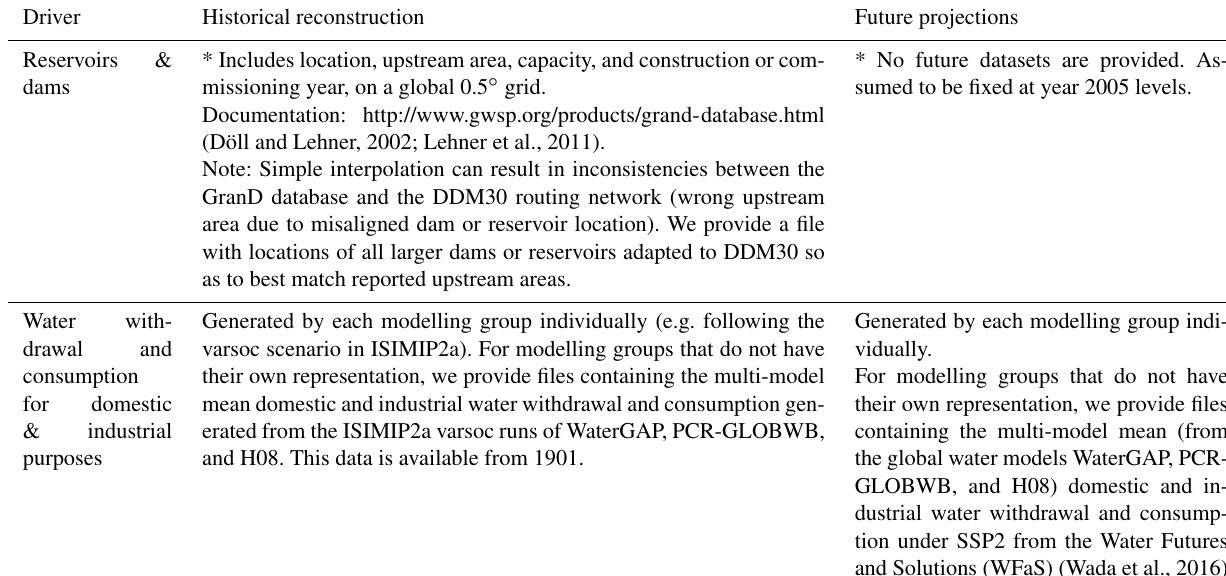
Table 4. Representations of socio-economic drivers for the historical simulations (histsoc, Group 1) and the future projections accounting for changes in socio-economic drivers (rcp26soc or rcp60soc, Group 3). * at the beginning of an entry means that it is mandatory to use the dataset(s) provided (if applicable), for reasons of harmonization across models. In other cases, datasets are provided only in support of modelling groups who may need them, but groups are free to use other data or generate the data based on their own simulations following the rules described